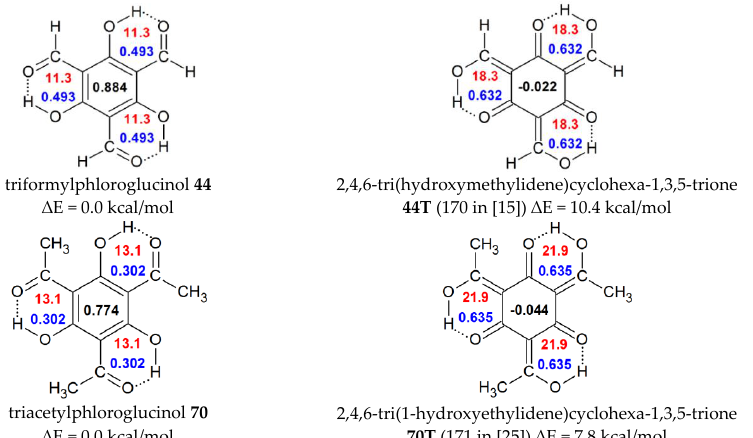
Figure 2. The transfer of aromaticity in triformyloglucinol 44 and triacetylphloroglucinol 70 from the ipso -ring to the enolic system. Values of quasiHOMA (in blue) and E HB (in red) were given in the centre of the HB-ring, whereas the HOMA value was given in the ipso -ring.